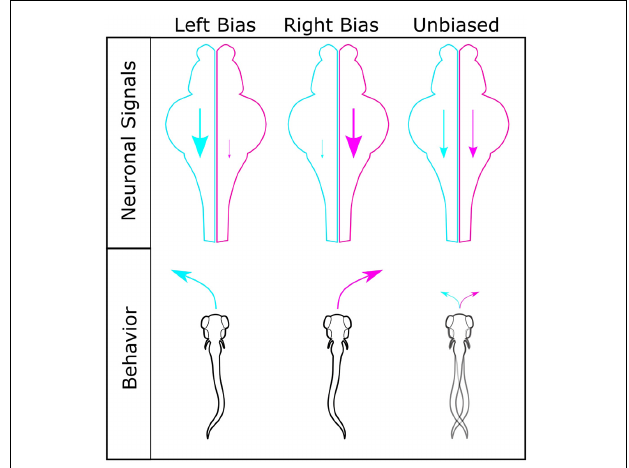
FIGURE 7 | Model for generating different turning types. Interhemispheric differences in turn bias driving motor signals are a potential mechanism for establishing turning types. Left (cyan) and right (magenta) hemispheres shown for left, right, and unbiased motor types, with corresponding motor drive shown by scale of descending arrow. For individuals with robust left or right turning types, a strong ipsilateral turn bias signal persists in a single hemisphere, with limited conflicting input from the contralateral hemisphere. In individuals with similar turn bias drive from both hemispheres, no single turn direction persists due to conflict between hemispheres, resulting in lower bias ratios and unbiased turning